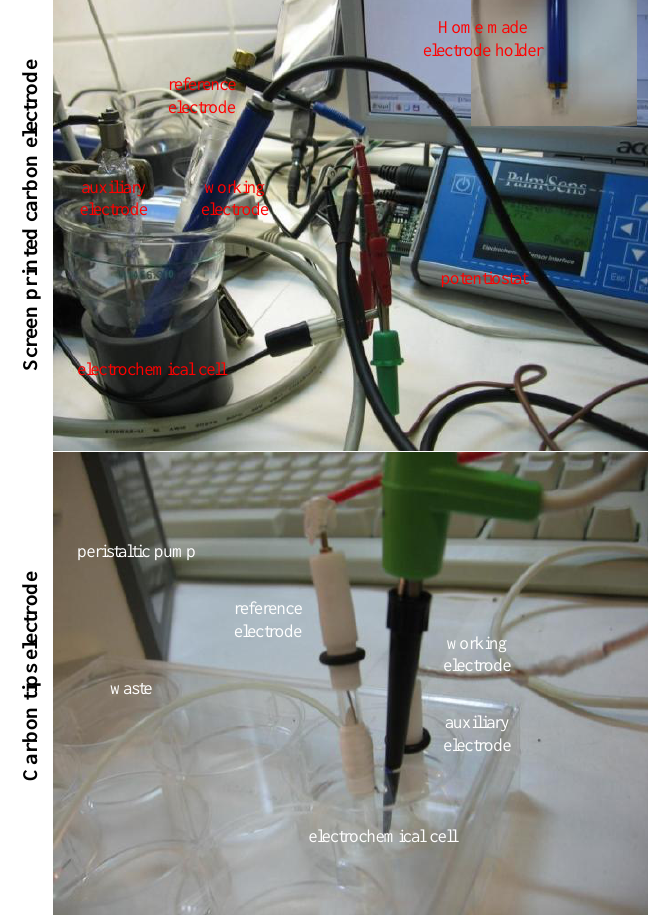
Figure 2. Photos of screen printed carbon electrode and/or carbon tips electrode connected to PalmSens